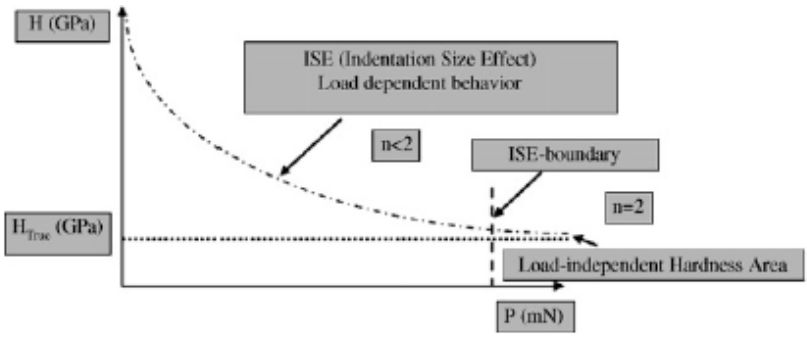
Figure 27. Schematic plot of the ISE behaviour [90]. Reproduced with permission